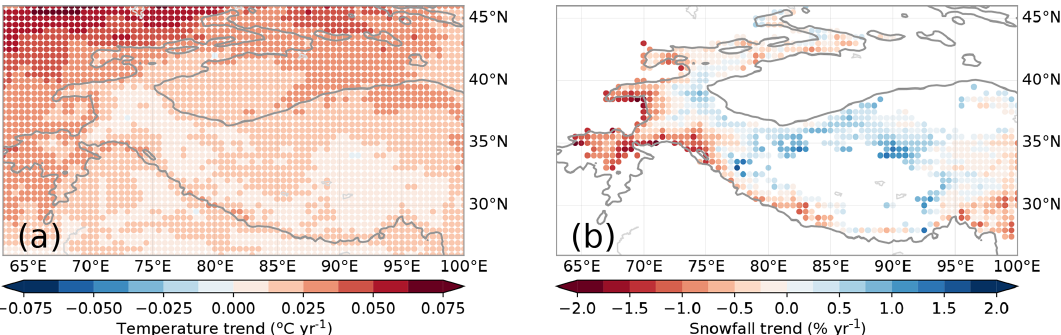
Figure 8. Trends between 1980 and 2010 of temperature in the melt season (a) and annual snowfall (b) , averaged over 0 . 5 ◦ × 0 . 5 ◦ bins for clarity. Regions with monthly snowfall of less than 10mm were masked out. The 2000m elevation contour is indicated by a solid line.